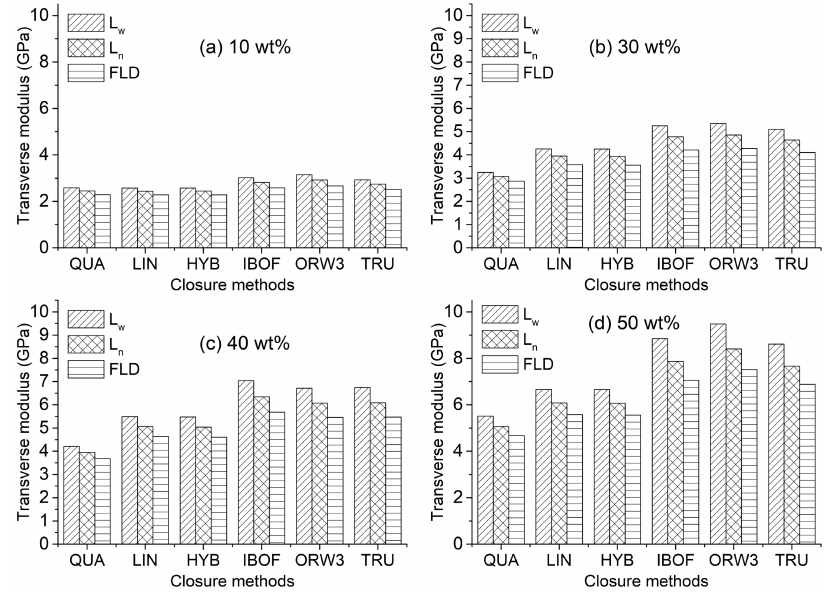
Figure 5. Predicted transverse modulus at the Hele-Shaw region using Halpin-Tsai (HT) model for ( a ) 10 wt%, ( b ) 30 wt%, ( c ) 40 wt%, and ( d ) 50 wt% glass fiber polypropylene composites. Various closure approximations and length parameters were used in the